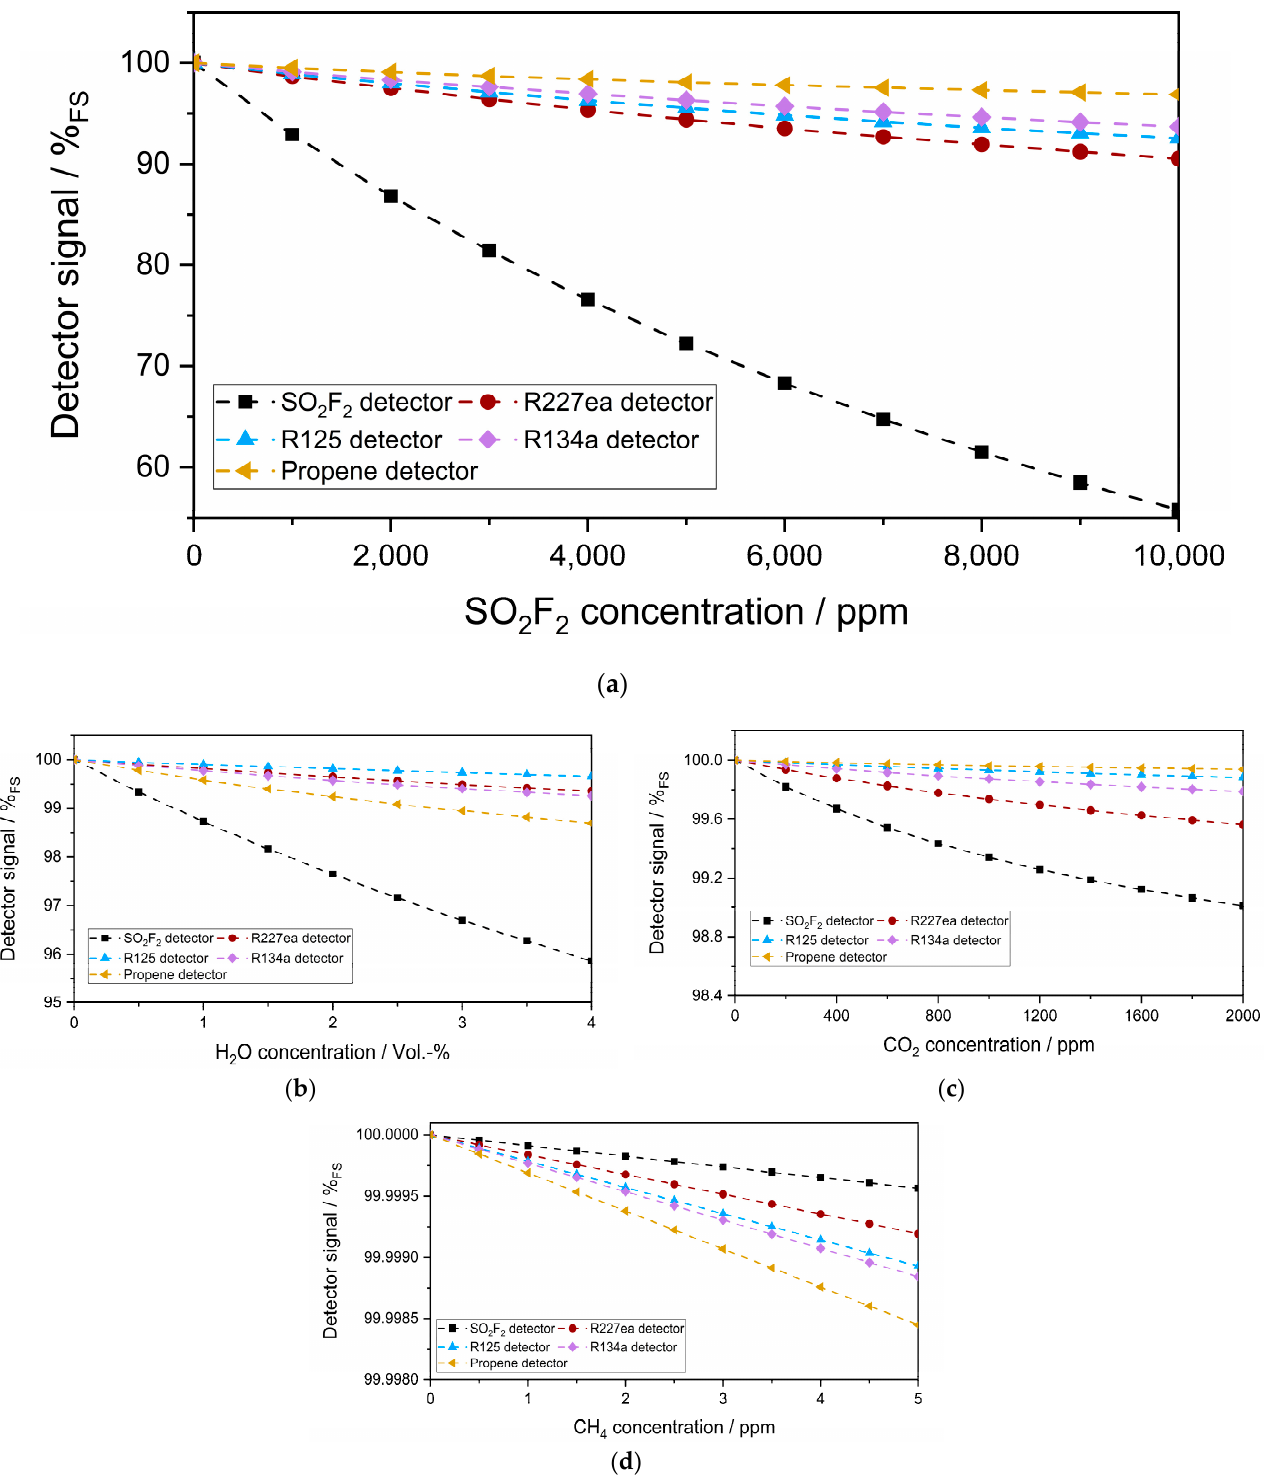
Figure 7. ( a ) Simulated sensitivity of the photoacoustic detectors to 0–10,000 ppm SO 2 F 2 in the absorption cell (50 mm length) and the cross-sensitivity to ambient H 2 O (0–4 Vol.-%) ( b ) and ambient CO 2 (0–2,000 ppm) ( c ) as well as ambient CH 4 (0–5 ppm) ( d ).